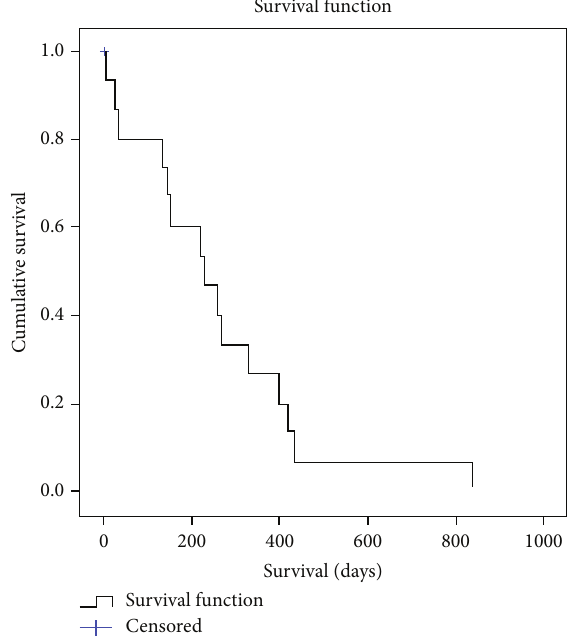
Figure 5: Kaplan Meier survival curve showing the survival periods ofthosewhounderwentcolonicstent.Themeansurvivaltimeinour cohort was 8.6